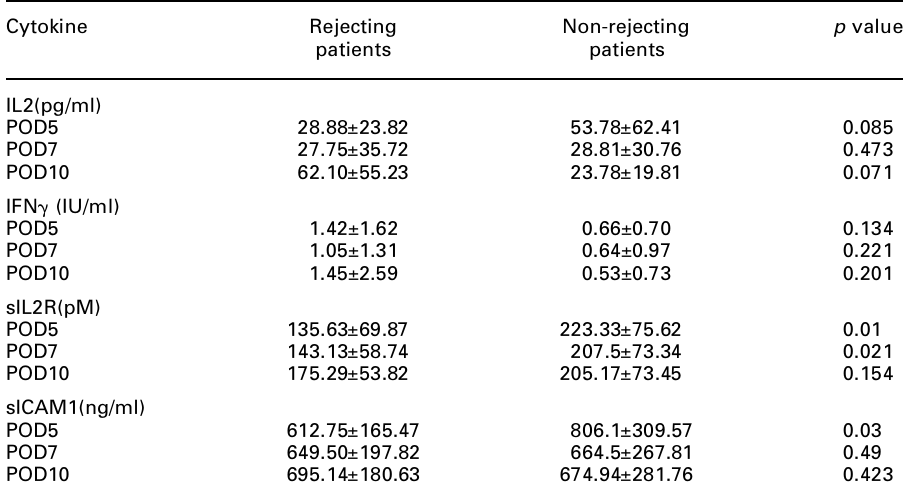
Table 4. Th–1 cytokines and markers in liver transplant patients during OKT3 induction Cytokine Rejecting Non-rejecting patients